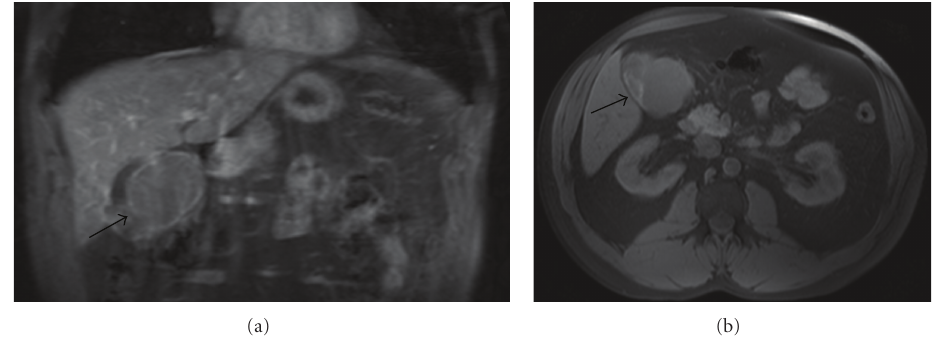
Figure 1: Neuroendocrine tumor of the gallbladder in an otherwise asymptomatic 47-year-old male. (a) Coronal T1-weighted image shows a 7 . 5 × 5 . 4cm irregular mass arising from the gallbladder bed. (b) Coronal T1-weight image again illustrating the large heterogeneous mass in the gallbladder fossa.